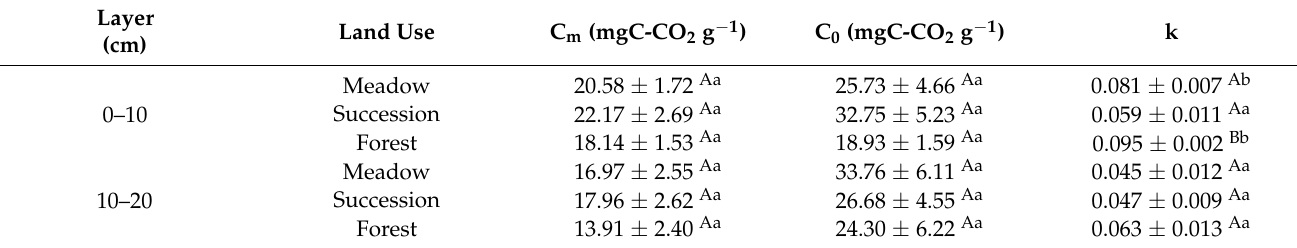
Table 3. Mean and standard error values of metabolic quotient (qCO 2 ), microbial quotient (qMIC) and mineralization quotient (qM) results. The lowercase letters indicate differences between